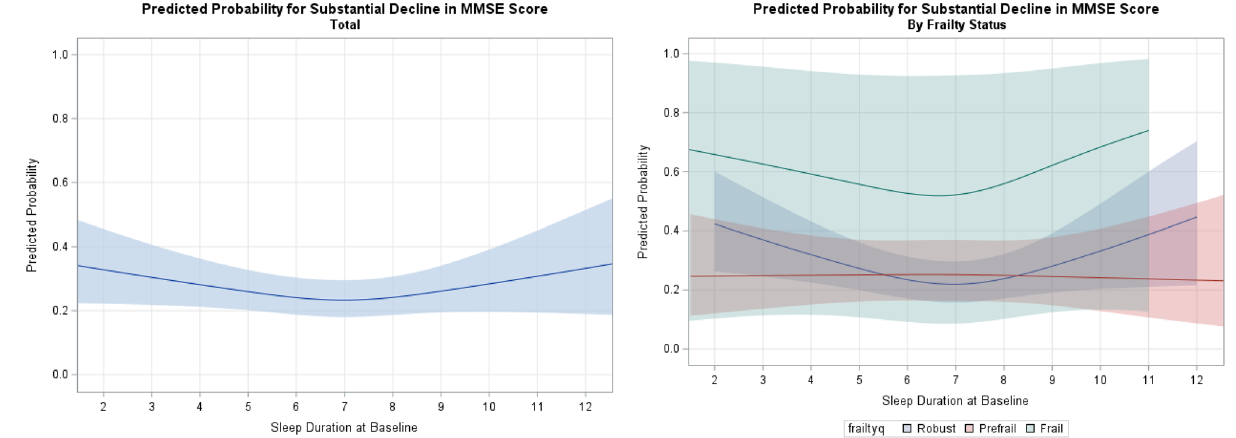
Figure 1. Restricted cubic spline plots of predicted probability of MMSE decline for total sleep duration. MMSE mini-mental status